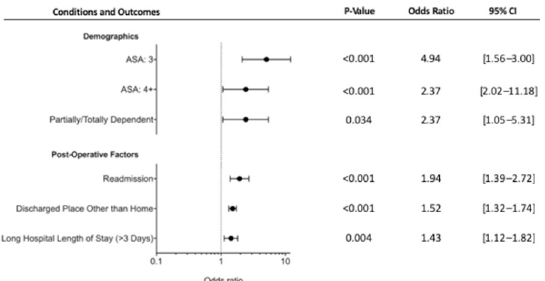
Fig 1. Binary logistic regression: Factors independently associated with HCAHPS survey nonresponse. Forest plot depicting the significant variables from the multivariate regression on both demographic and post-operative factors highlighting HCAHPS non-responder bias following total knee